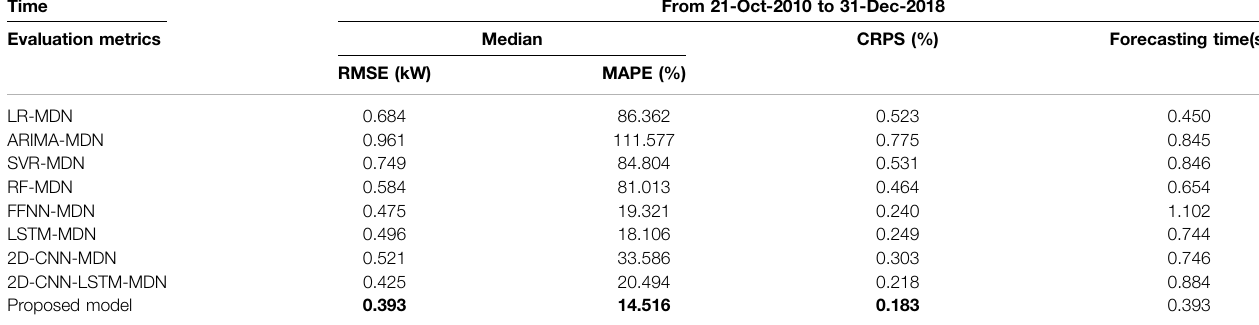
TABLE 8 | Load forecasting evaluation on the testing set. Time